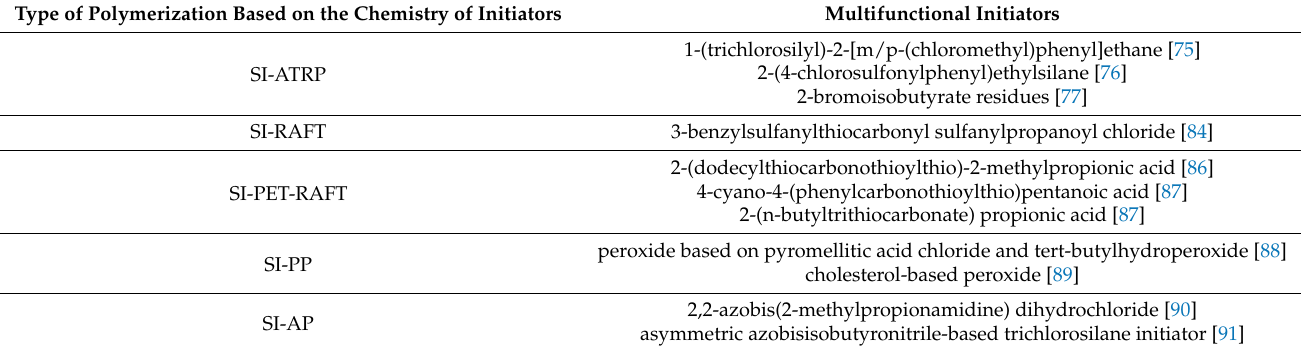
Table 1. The examples of multifunctional initiators for surface-initiated